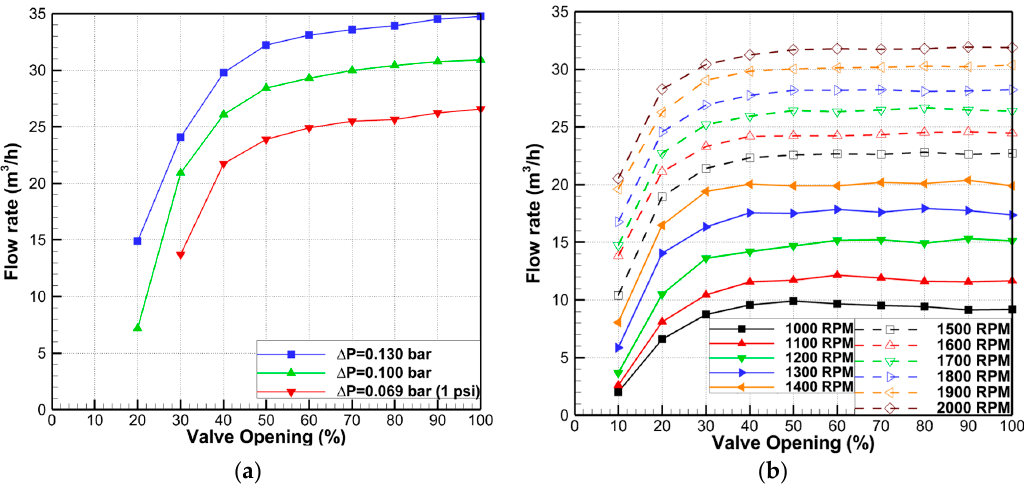
Figure 9. Flow characteristic of the globe valve. ( a ) Inherent condition; ( b ) installed condition.